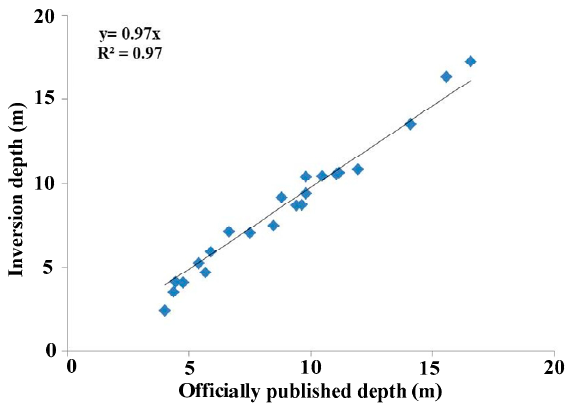
Figure 10. Scatter plot between the depth inversion result and the officially published value.